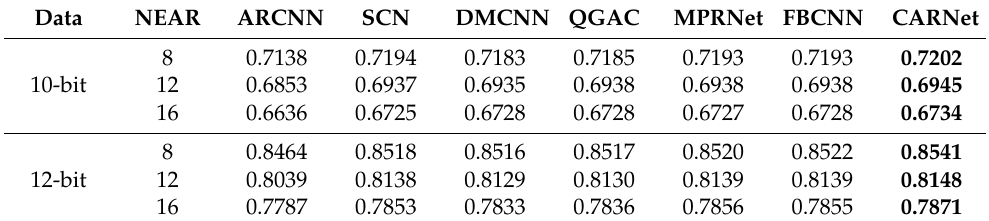
Table 5. LS-SSIM results, data type: 10-bit (NEAR = 8) means a 10-bit remote sensing image